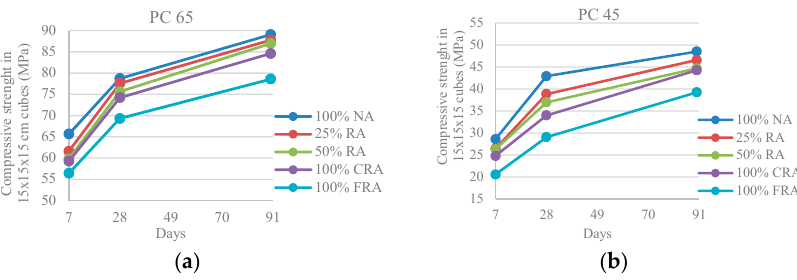
Figure 3. ( a ) Compressive strength in cubes at 7, 28 and 91 days (PC 65); ( b ) Compressive strength in cubes at 7, 28 and 91 days (PC 45).